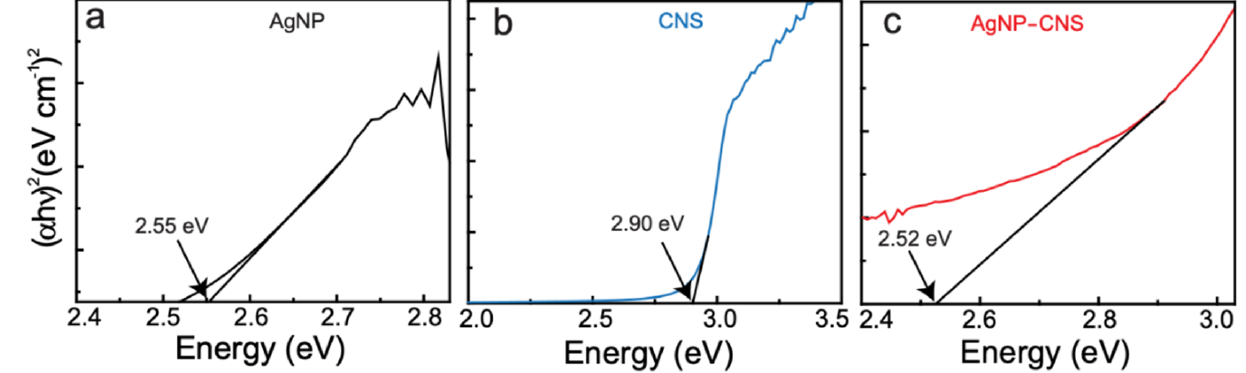
Figure 2. Tauc plots for ( a ) AgNPs, ( b ) CNSs, and ( c ) the AgNP–CNS nanocomposite. Table 1. Physicochemical characteristics of the prepared AgNPs, CNSs, and AgNP–CNS nanocomposite.